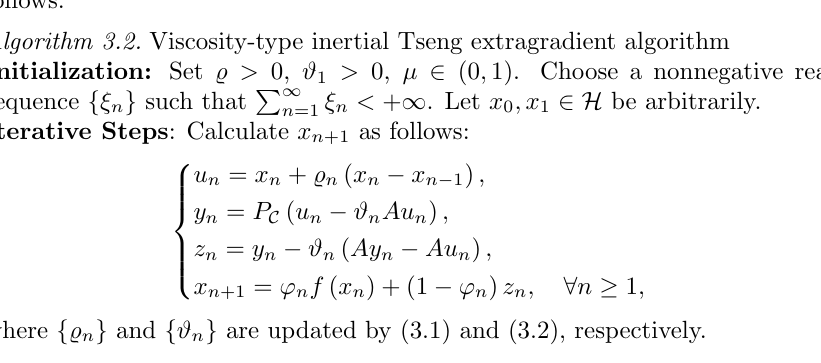
Algorithm 3.2. Viscosity-type inertial Tseng extragradient